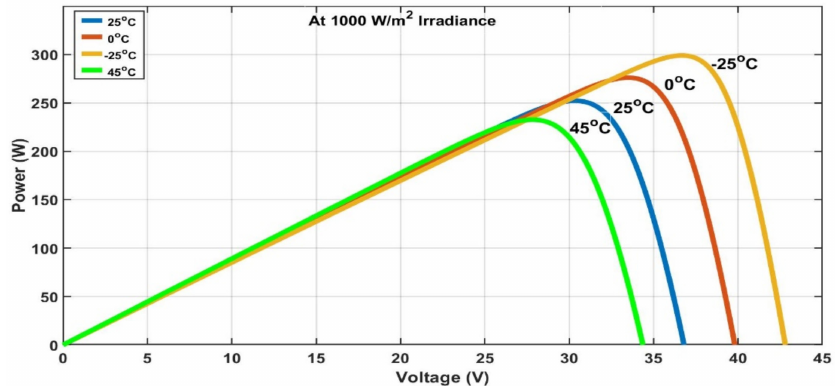
Figure 11. P-V curves with different temperatures at 1000 Wm 2 .